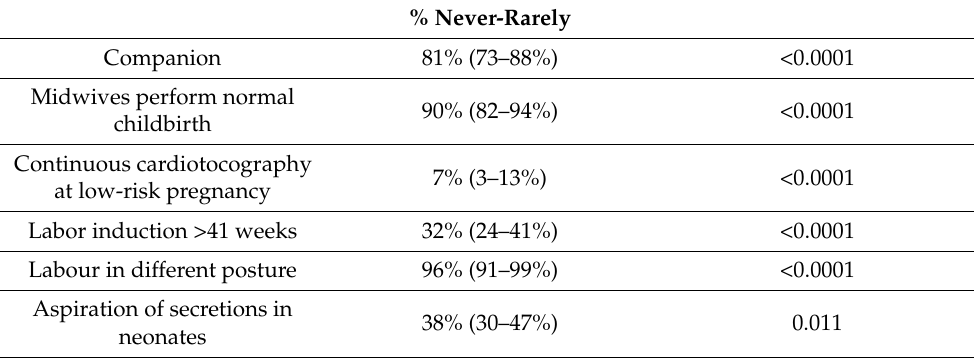
Table 3. Negative answers regarding the application of midwifery